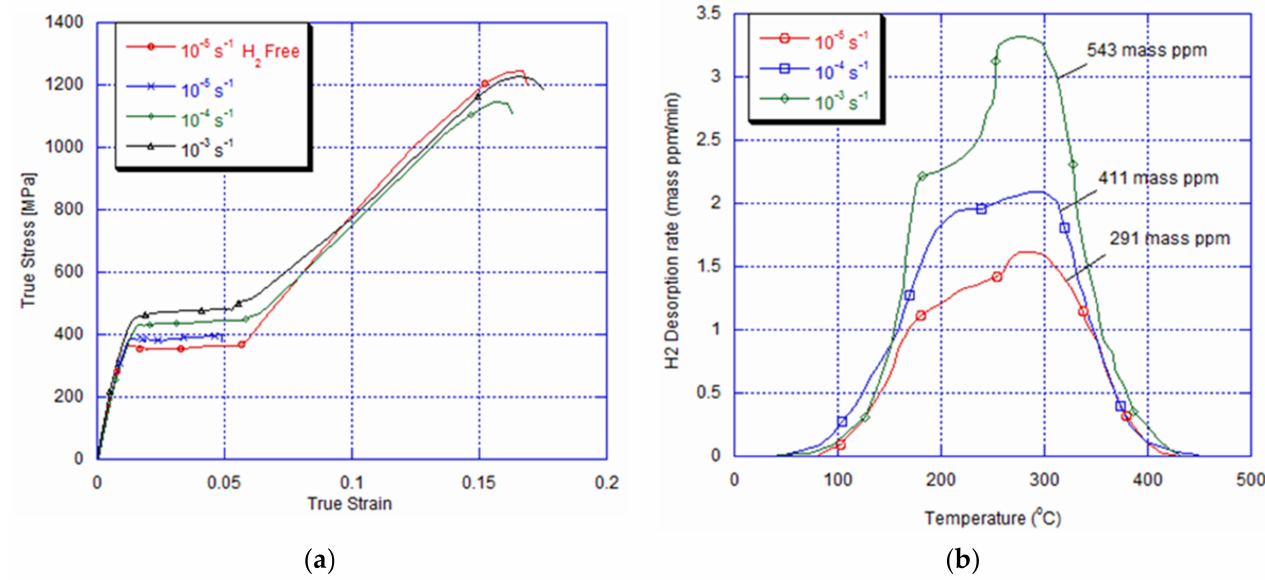
Figure 9. ( a ) Tensile curve at 10 − 5 s − 1 showing fracture after 13 cycles with imposed strain rate of 10 − 5 s − 1 , and ( b ) amount of absorbed hydrogen after the same number of cycles at 10 − 5 s − 1 , 10 − 4 s − 1 , and 10 − 3 s − 1